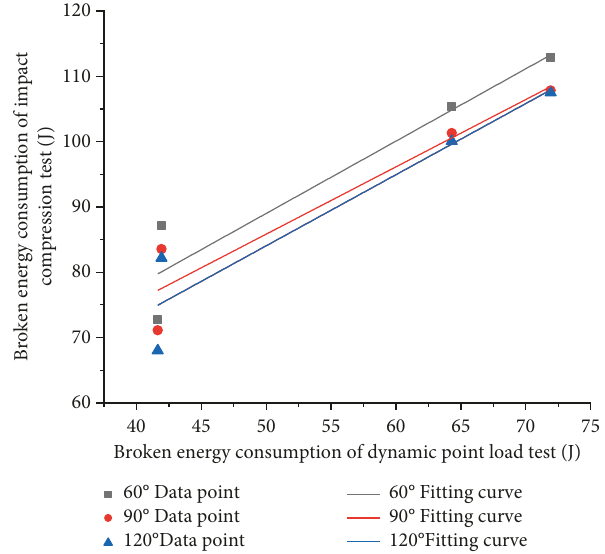
Figure 14: Comparison diagram of crushing energy consumption of load test at different conical angle